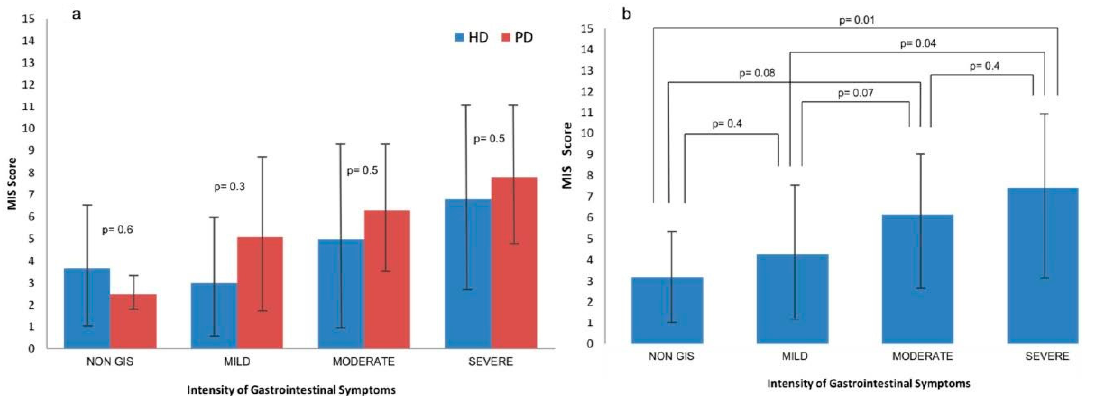
Figure 3. Prevalence of malnutrition (MIS) and the severity of GIS according to ( a ) dialysis modality, ( b ) all patients in renal replacement therapy together.